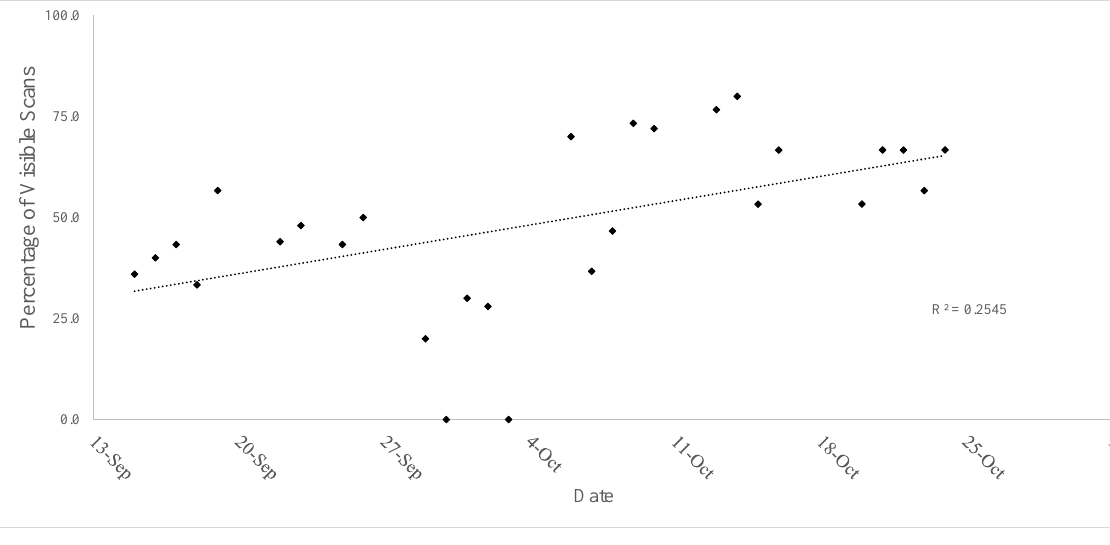
Figure 2. Daily activity levels of G1 as an example of gorillas daily activity throughout the